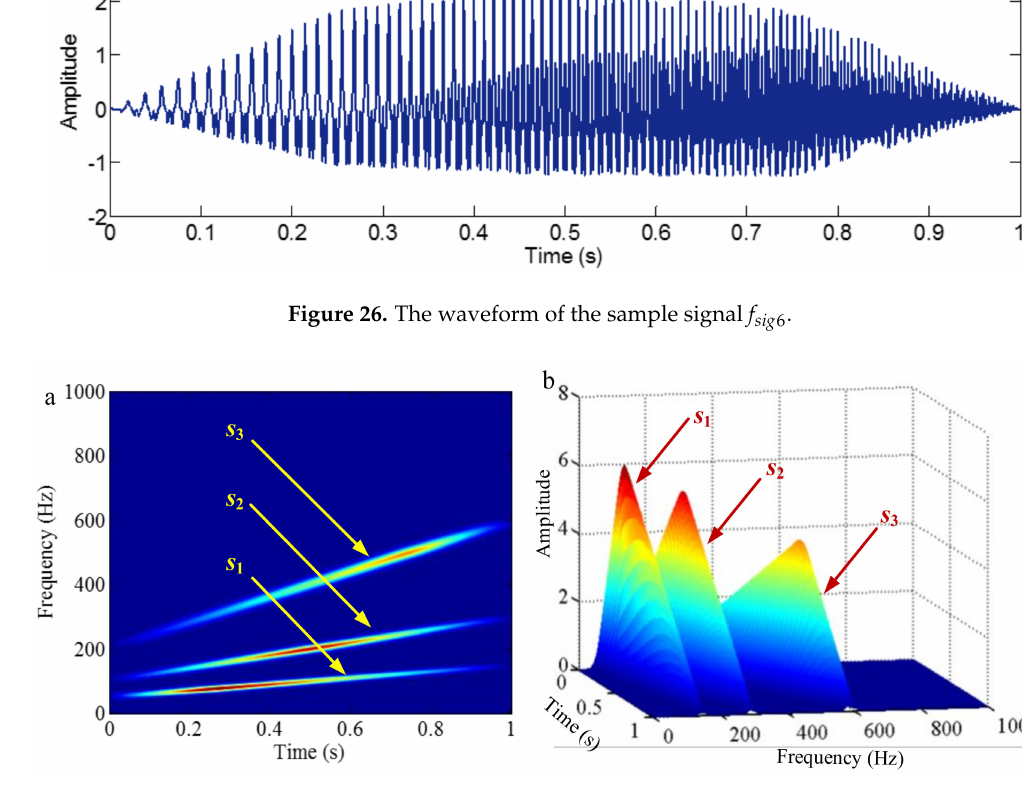
Figure 27. The STFT of the sample signal f sig 6 : ( a ) 2D figure and ( b ) 3D figure.